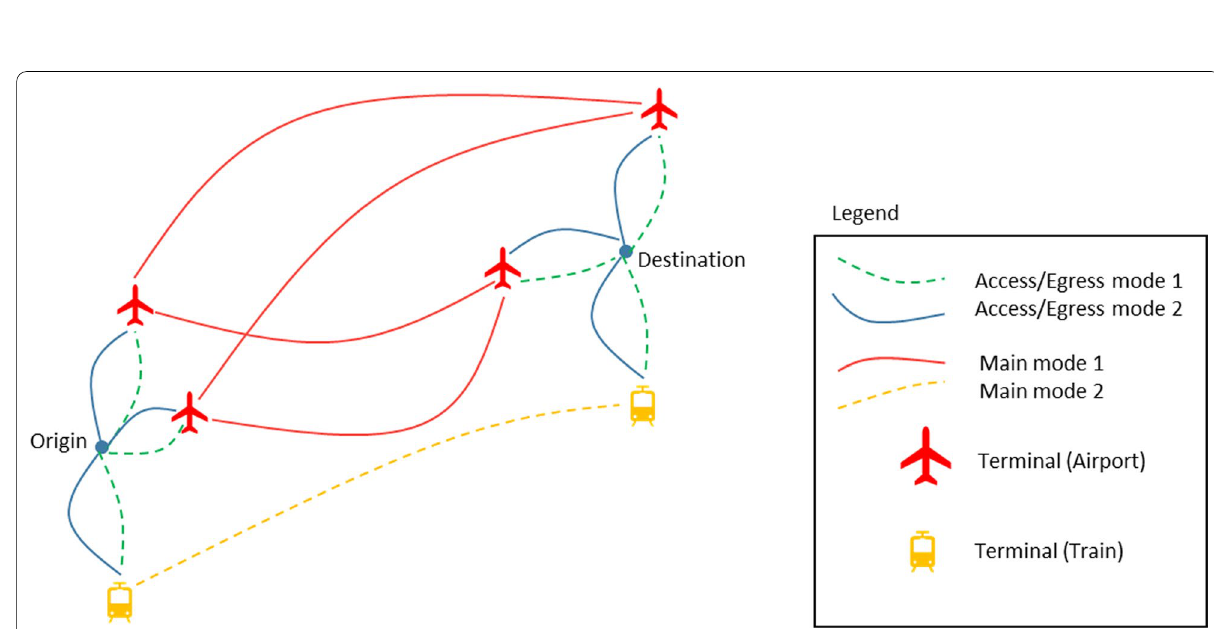
Fig. 6 Schematic figure of joint access/egress and terminal choice within main mode choice (Type 6)